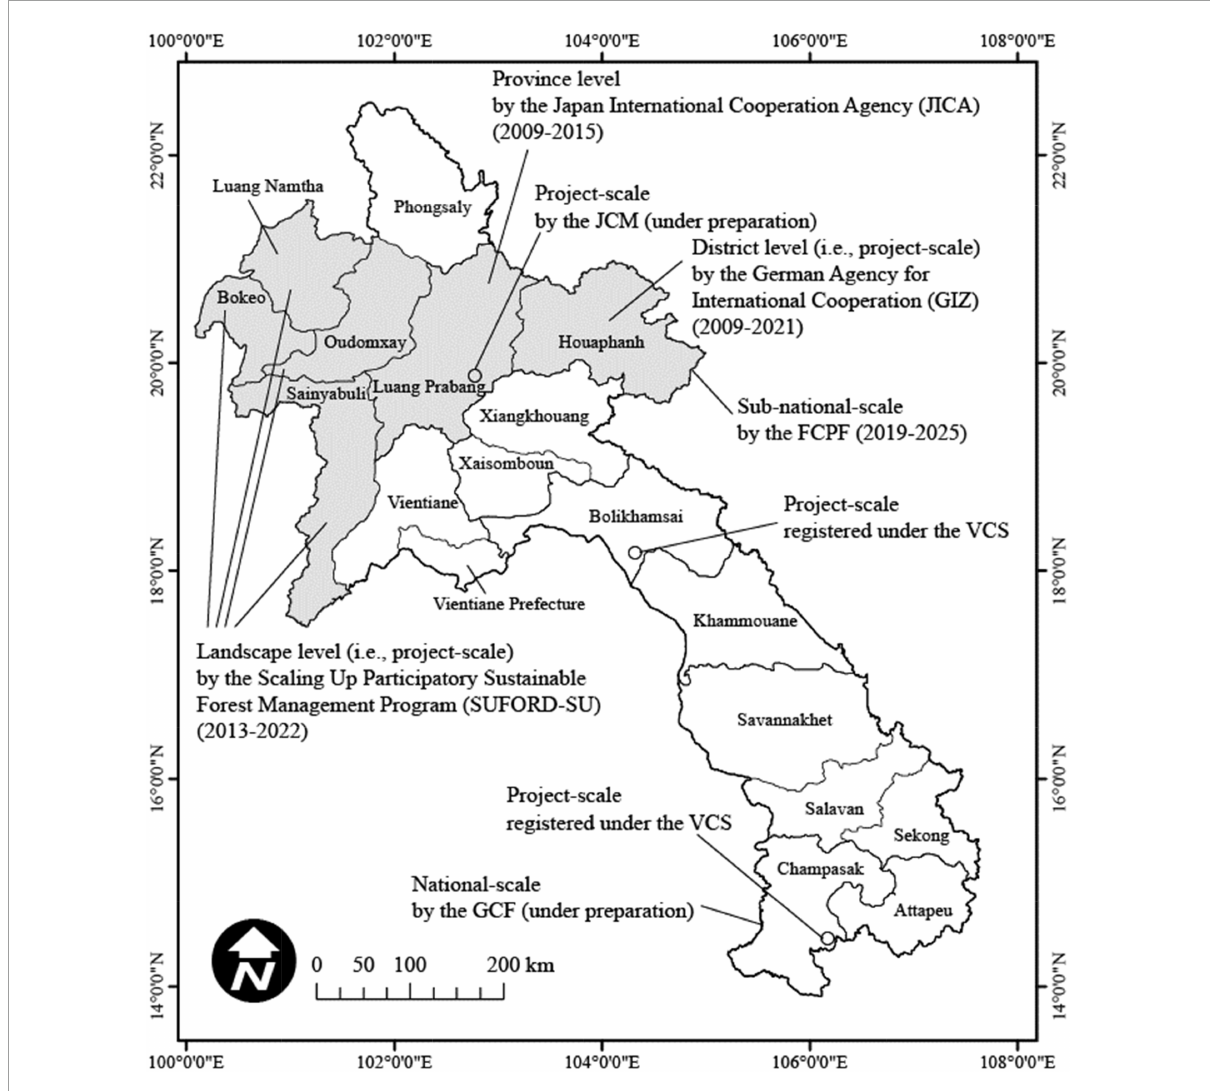
FIGURE1 Reducing emissions from deforestation and forest degradation (REDD+) activities in Lao People’s Democratic Republic. National-scale REDD+ activities have been introduced under the Green Climate Fund (GCF), sub-national-scale REDD+ programs in the six northern provinces have been developed under the World Bank’s forest carbon partnership facility (FCPF) Readiness Fund and Carbon Fund, and project-scale REDD+ activities including technical support and projects aimed at creating carbon credits have been implemented by the joint crediting mechanism (JCM) and the verified carbon standard (VCS), with REDD+ activities at various scales overlapping in some